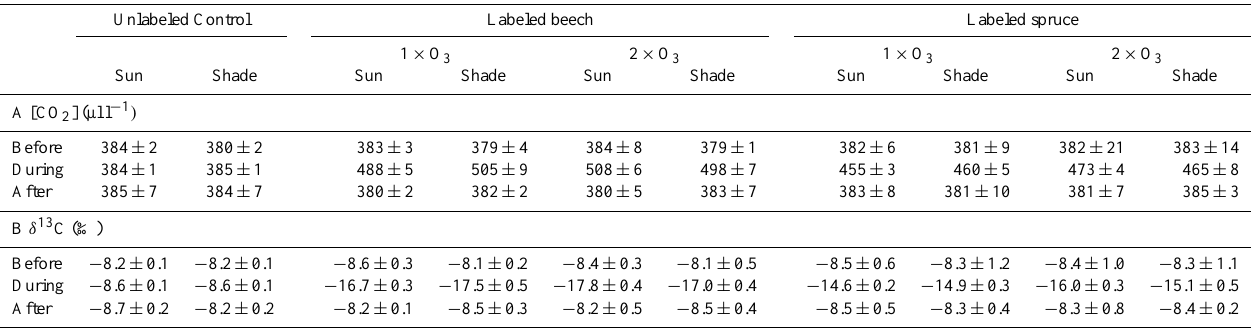
Table 2. (A) CO 2 concentration (µll − 1 ) and (B) δ 13 C (‰) in canopy air of labeled beech and spruce trees under 1 × and 2 × O 3 and one unlabeled control tree for each species. Data are presented for sun and shade crowns as means ± SE before ( n = 12h), during ( n = 18 to 19 days) and after ( n = 12h) label exposure.